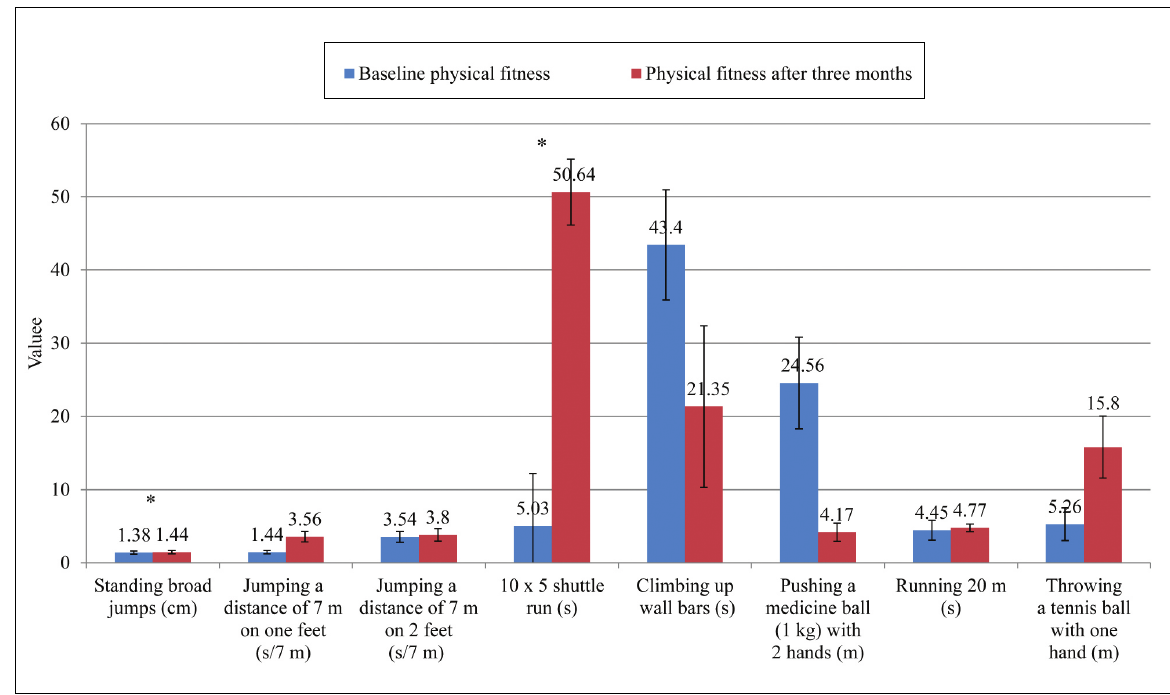
Note: * – p < .05 Figure 2. Changes of physical fitness in three months in the control group of boys